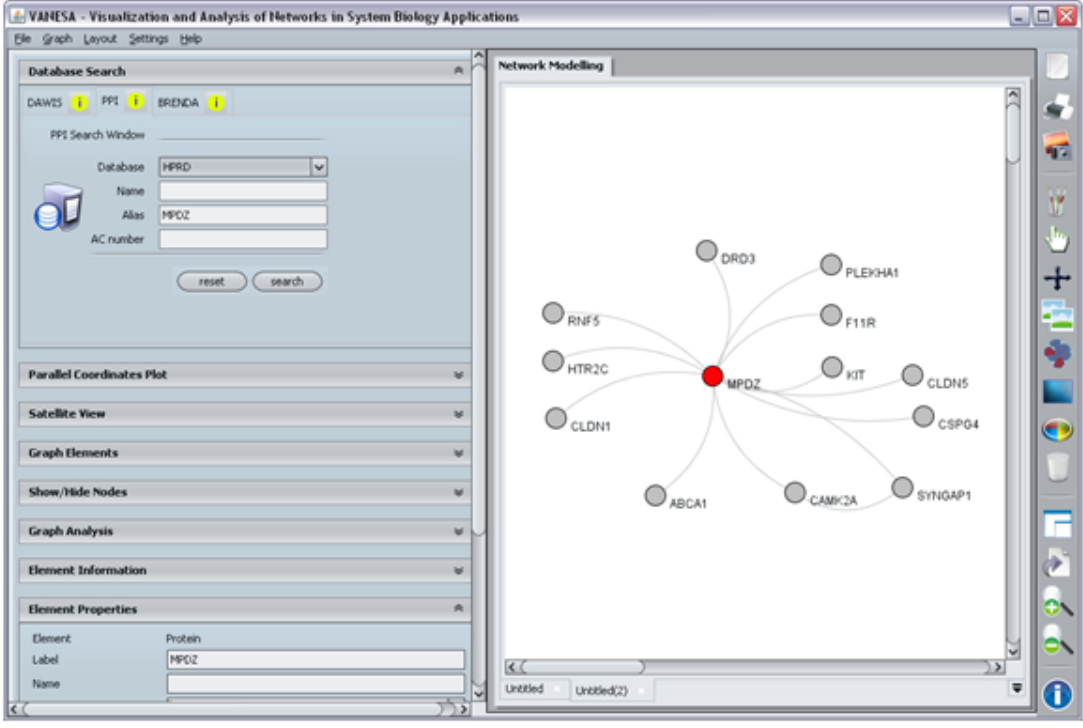
Figure 1: The relevant sub-network (from Fig. 2) of direct protein interactions with MPDZ, computed by the BioDWH integration of the HPRD database in VANESA.